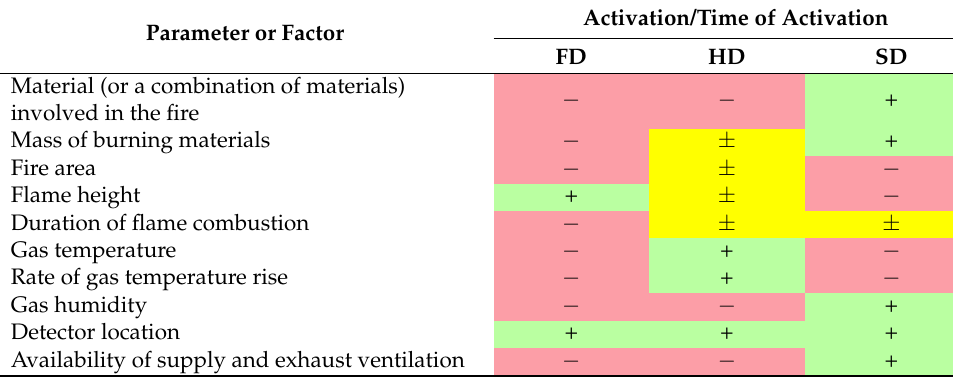
Table 7. Parameters and factors affecting the activation and time of activation of different types of fire detectors (FD, HD, SD) (“+” affects; “ − ” has a minimal effect; “ ± ” has a moderate effect). Activation/Time of Activation Parameter or Factor FD